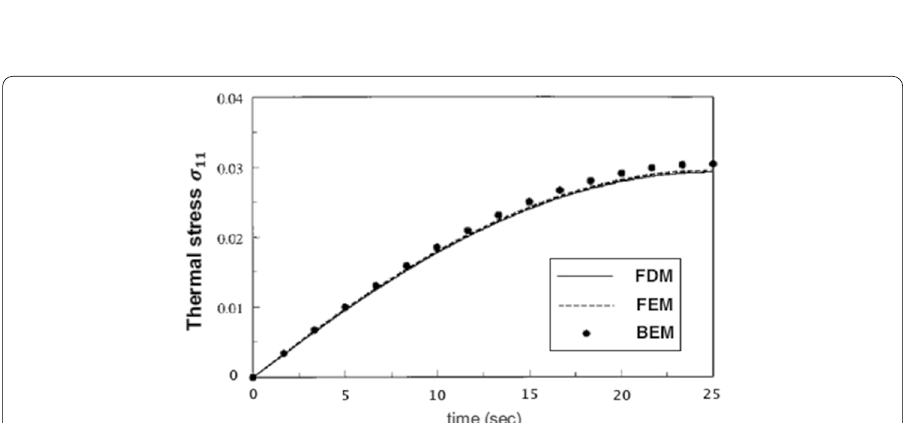
Fig. 13 Variation of the nonlinear thermal stress σ 11 with time τ for FDM, FEM and